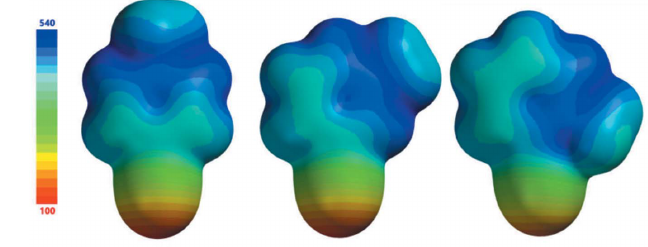
Figure 10 Electrostatic potential maps (kcal mol (cid:3) 1 ) for the 4-CMP + (left), 3-CMP + (center) and 2-CMP + (right) cations. Note the large range of 440 kcal mol (cid:3) 1 . The strong electron-withdrawing ability of the cyano group results in a significantly less positive partial charge for that part of the molecular ion.